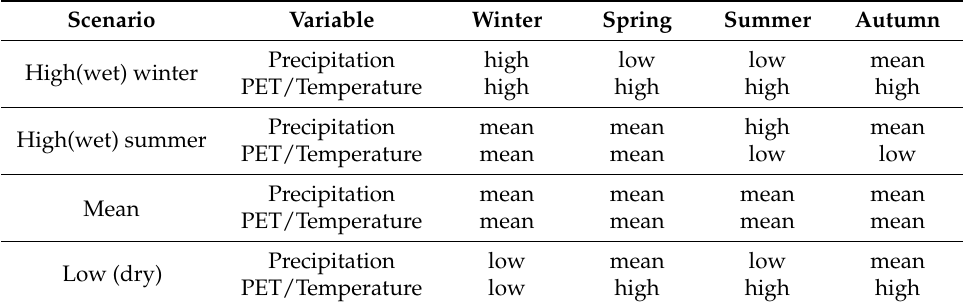
Table 1. The CCI-HYDR impact scenarios and related changes in precipitation, temperature, and potential evapotranspiration (PET)